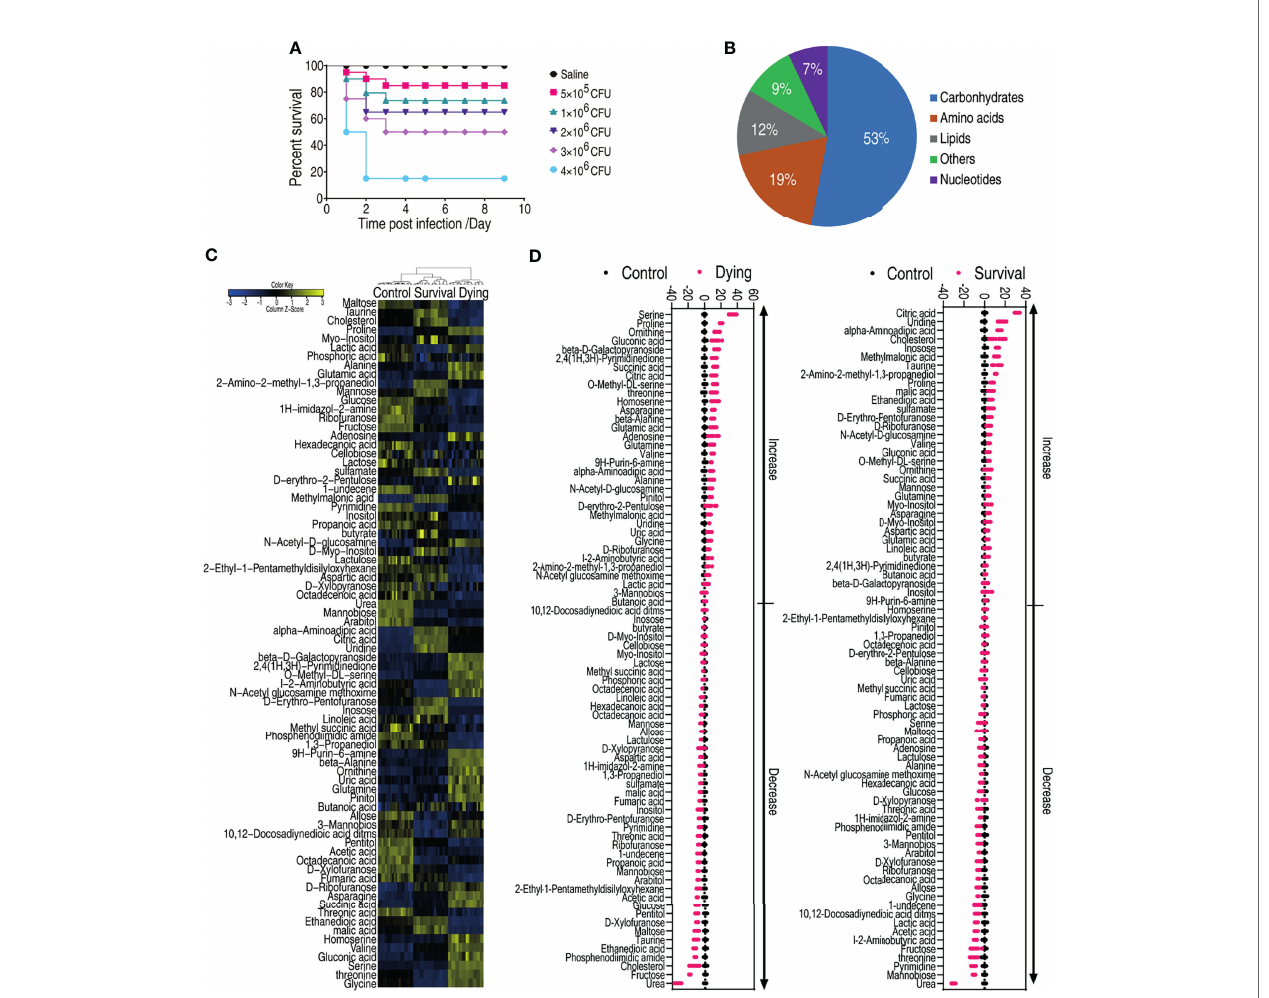
FIGURE 1 | Dying and survival crucian carp have different metabolomic pro fi les. (A) Determination of LD 50 of crucian carp to A. hydrophila infection. (B) Functional categories of the differential metabolites. (C) Heat map of unsupervised hierarchical clustering of differential metabolites (row). Yellow and blue indicate the increase and decrease of the metabolites scaled to mean and standard deviation of row metabolite level, respectively (see color scale). (D) Z scores (standard deviation from average) of the dying group (left panel) or survival group vs. control group (right panel) which correspond to the data shown in (C) . Each point represents one technical